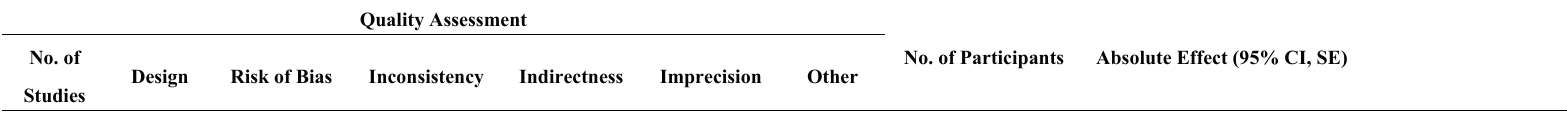
Table 4. Associations between outdoor time and acute sedentary behaviour.